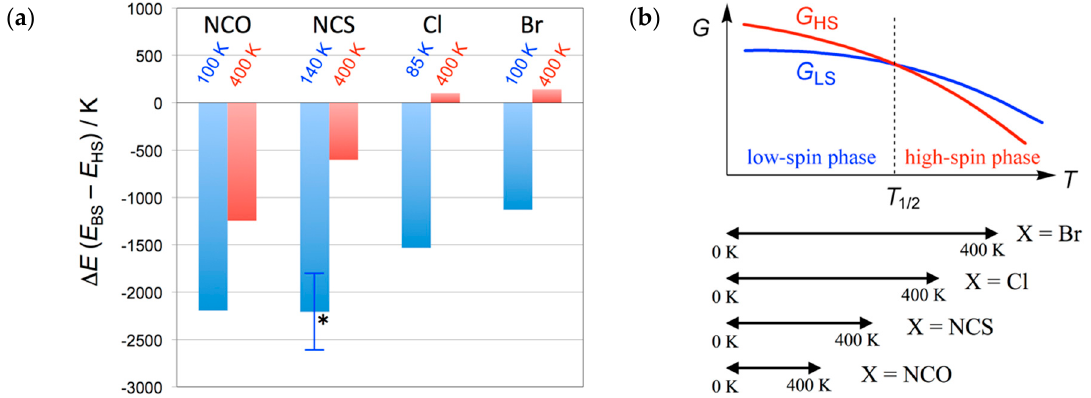
Figure 6. ( a ) Temperature dependence of the energy gap between the broken-symmetry singlet state (BS) and quintet state (HS) on the determined structures of 4 (X = NCO), 3 (NCS), 2 (Cl), 1 (Br). The temperatures of structure determination are noted. An asterisk indicates an averaged value of the two independent molecules. For comparison on the same level, the data of 2 were updated as ∆ E / k B = − 1533 and + 102 K at T = 85 and 400 K, respectively. ( b ) A schematic Gibbs energy diagram together with the experimental temperature windows for spin-transition materials 1 – 4